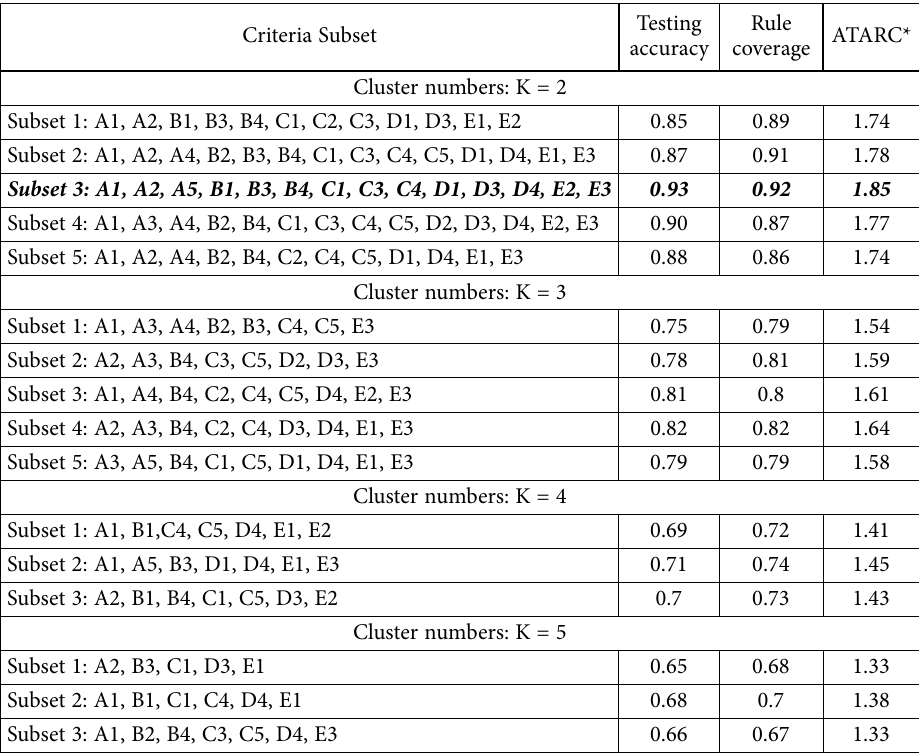
Table 2. The selected criteria by FRST-ACO